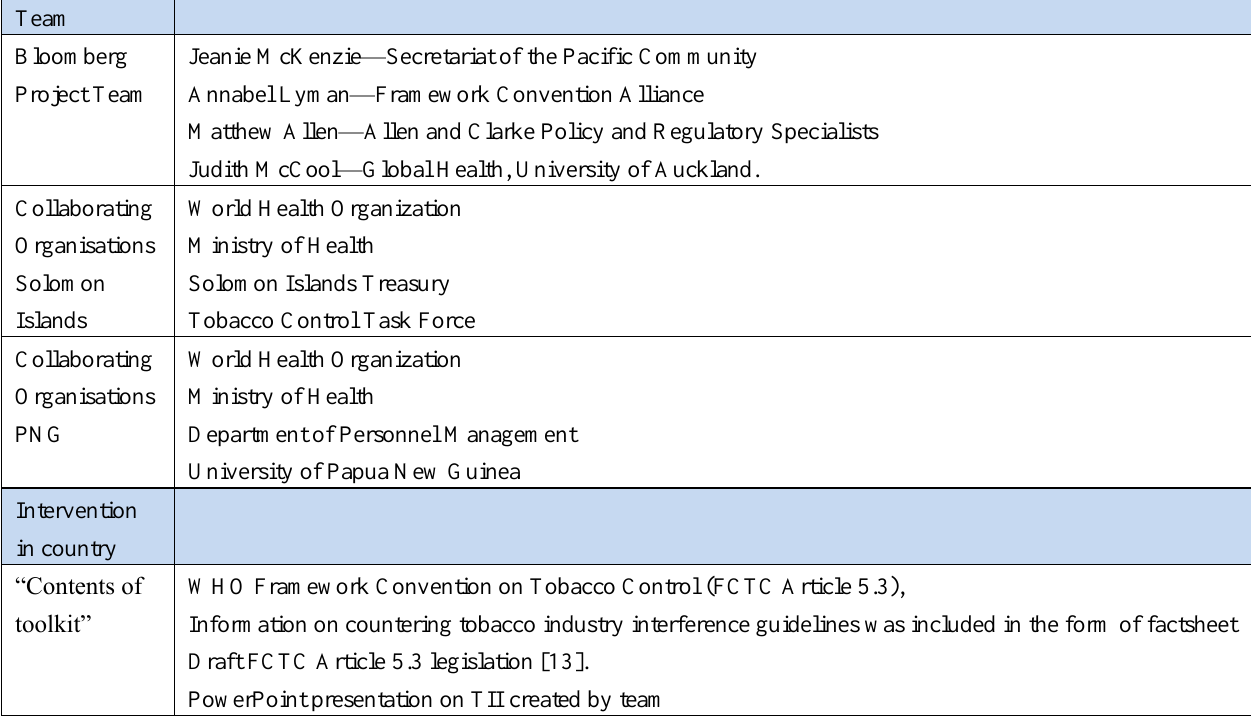
Table 1. Project team, activities and